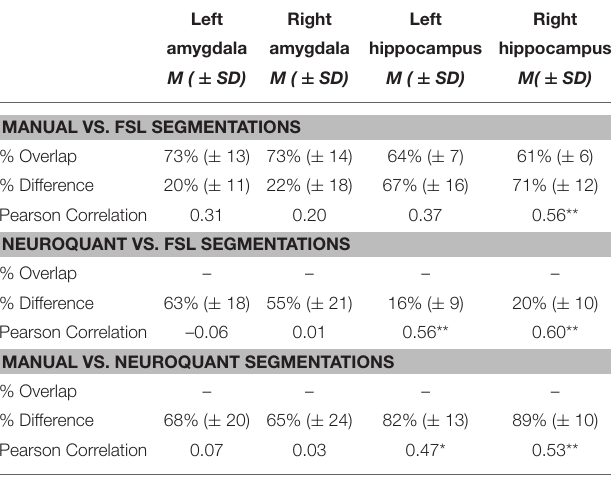
TABLE 3 | Separate multivariate linear regression analyses of family aggression exposure and manual and automated bilateral hippocampi and amygdalae segmentations, adjusting for age, gender and total brain